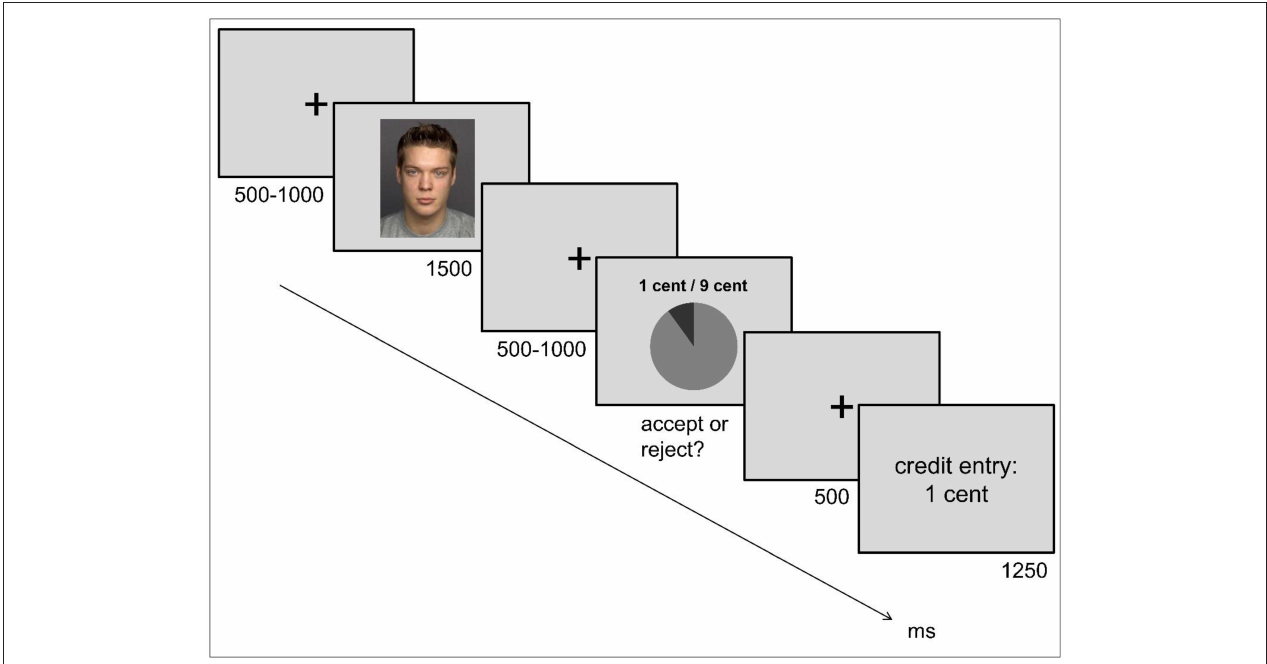
FIGURE 1 | Trial Scheme of the Ultimatum Game. Each trial started with a fixation cross shown for a variable time of 500–1000ms, followed by a photograph of a proposer for 1500ms, and another fixation cross presented for 500–1,000ms; then, participants received an offer about splitting 10 cent which they had to accept or reject via button press. Afterwards, a fixation cross was presented again for 500ms. Participants received feedback about the sum booked to their account before the next trial started after 1,250ms. Portrait taken from Ebner et al. (2010) for which the depicted individual gave consent to be displayed in research-related